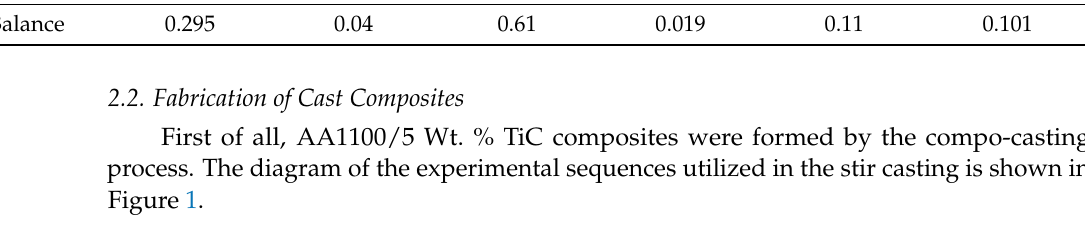
Figure 2. Diagram design of the APB. A 100 tons’ hydraulic press machine was used to handle the pressing process. The composite produced after one step of APB was cut into two halves and preheated at 300 °C for 6 min. In the following, two bars of MMC were loaded onto each other after surface cleaning. The fabricated sample was cut in two halves and the process of cleaning and warm press bonding with a 50% of thickness reduction was repeated up to eight steps. The spec- ification of the APB process is proposed in Table 2. Increasing the plastic strain during the cumulative pressing leads to a good scattering of TiC particles. The tensile test specimens were prepared based on the ASTM-E8M standard which was shown along the longitudi- nal direction in 25 and 6 mm dimensions, Figure 3. The tensile strain for conducting the tensile test was 1.67 × (cid:2869)(cid:2868) (cid:3127)(cid:3120) (cid:3046)(cid:3032)(cid:3030) on a Hounds field H50KS machine. Additionally, the standard ASTM-E384 was used to set up the hardness test.